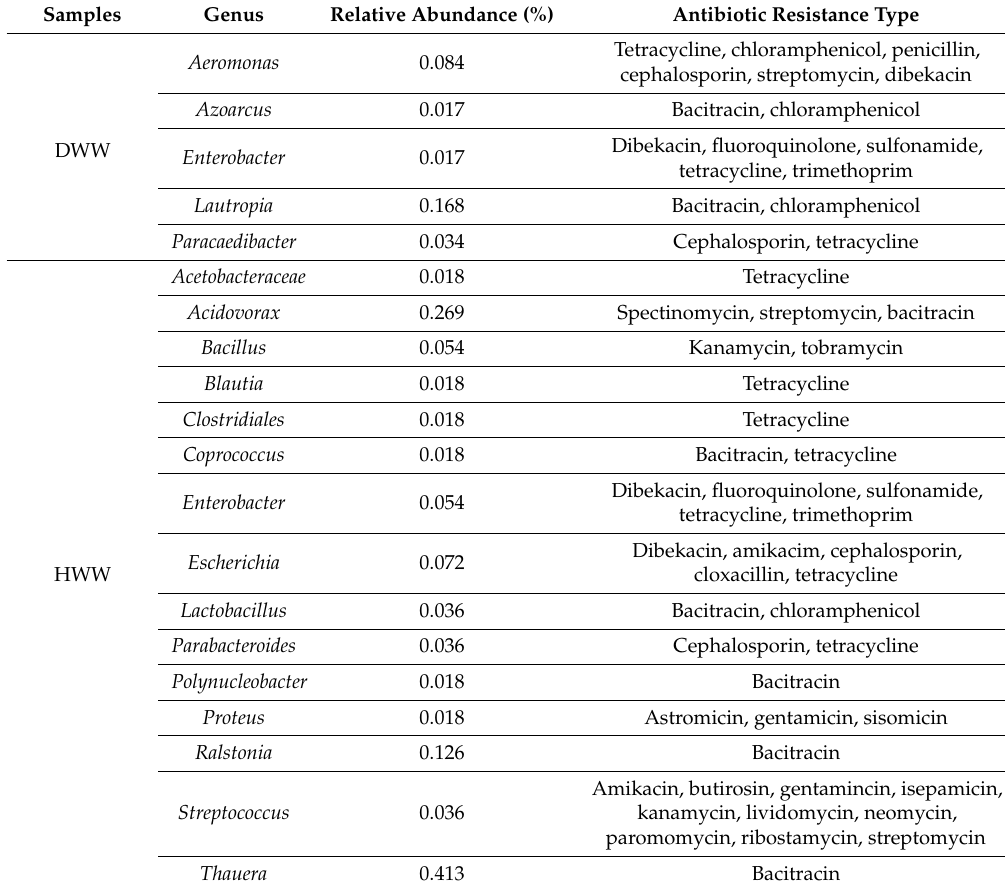
Table 2. Genus and antibiotic resistance types matched from the antibiotic resistance gene database (ARDB). Minor genera groups (<0.5% relative abundance) were matched using the